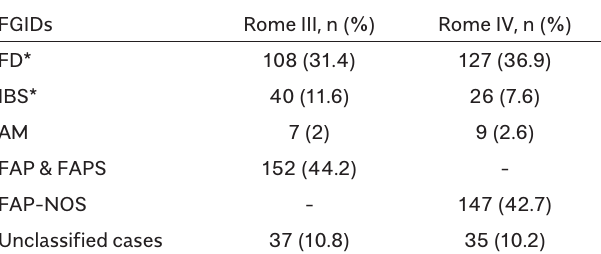
Table 3. The Comparison of the Diagnoses of the Patients with Functional Gastrointestinal Disorders According to Rome III and Rome IV Classifications FGIDs Rome III, n (%)